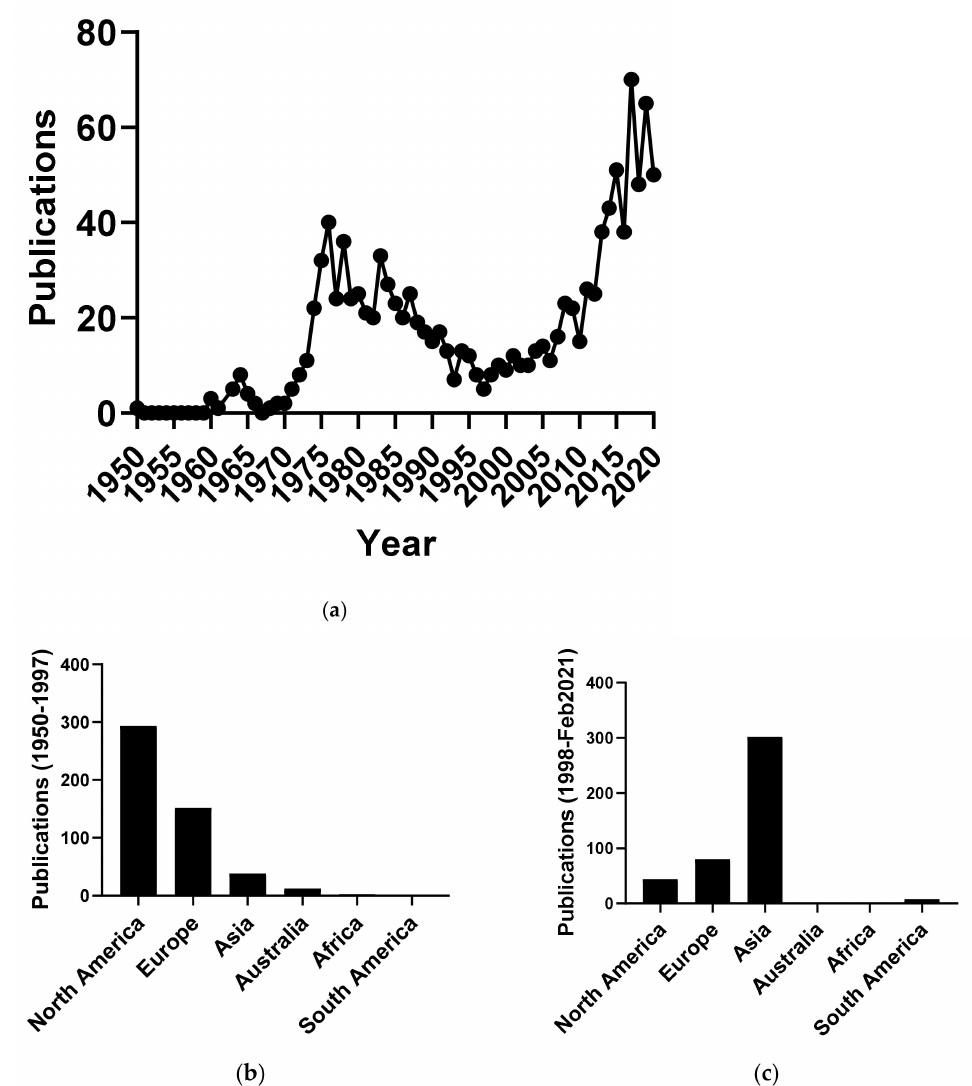
Figure 1. Number of publications on cordycepin by year and geographical origin. ( a ) Number of publications on cordycepin per year of publication 1950–2018; ( b,c ) Geographical distribution of the affiliation of the corresponding authors of publications on cordycepin in two periods: ( b ) 1950–1997 and ( c ) 1998–February